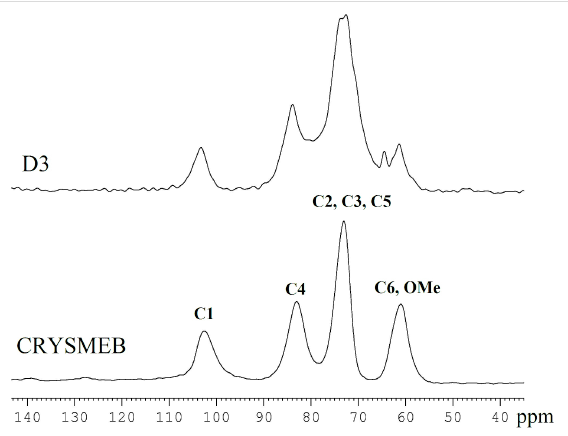
Figure 4: 13 C { 1 H} CP-MAS spectra of native CRYSMEB and polymer D3. Peak assignment is given on CRYSMEB spectrum.